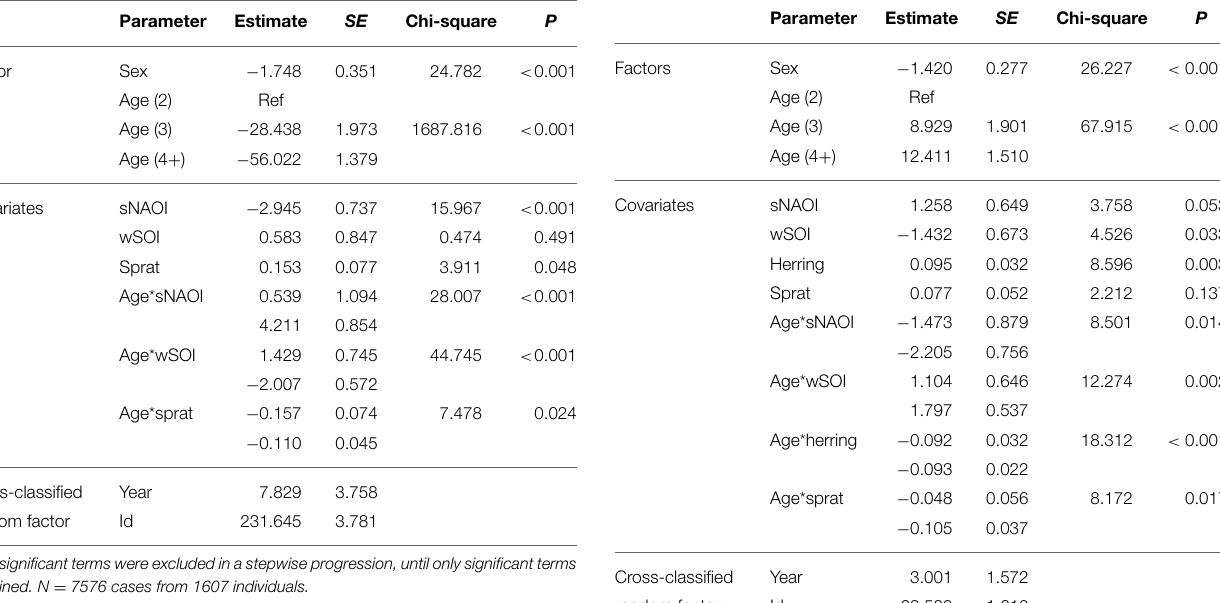
TABLE 4 | Minimal adequate additive cross-classified random effect model describing significant effects of age, sex and environmental covariates on arrival mass of common terns between 1994 and